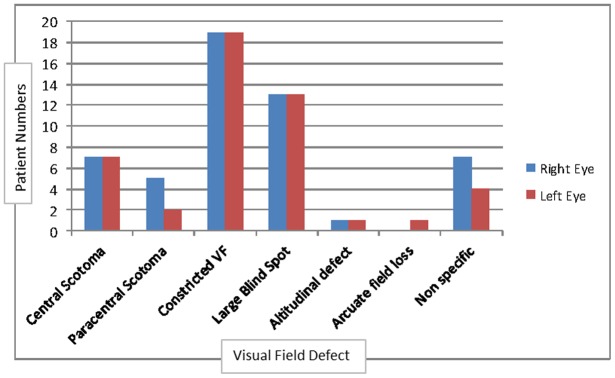
Frequencies of Visual Field Defects.Constricted VF – Constricted Visual Field.